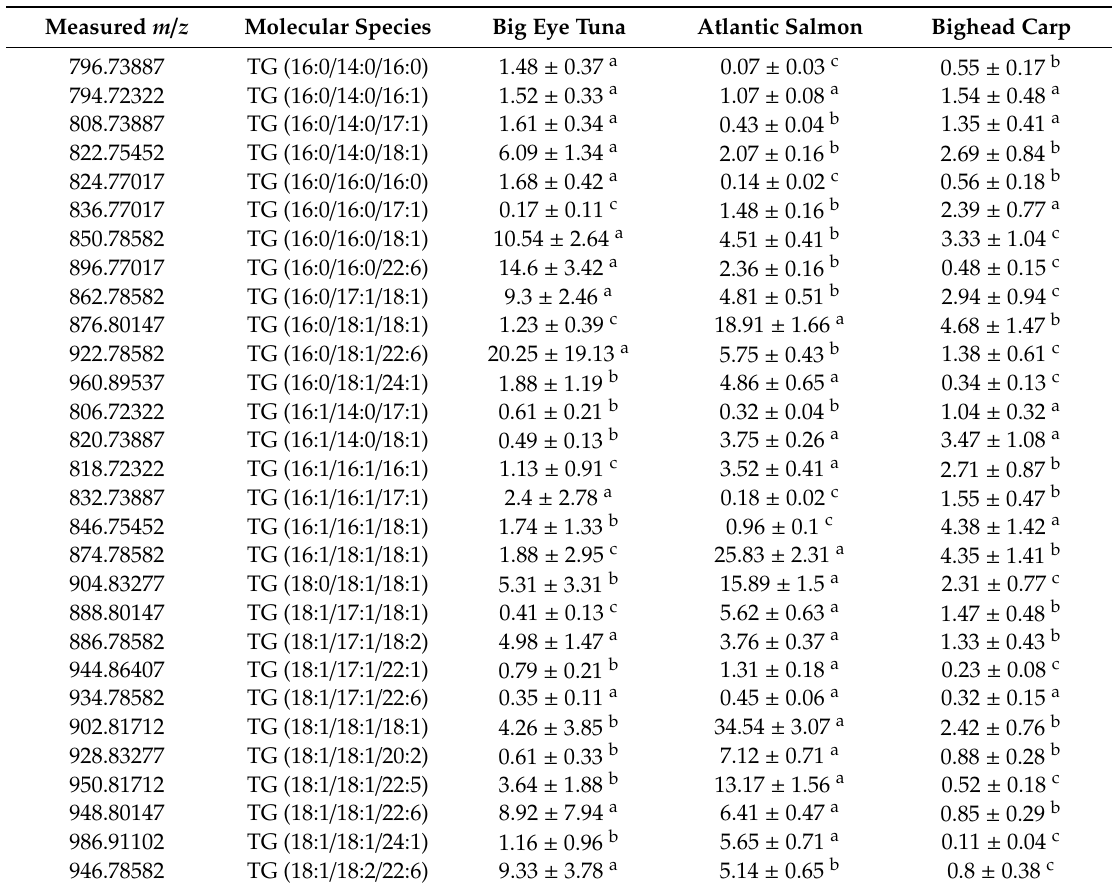
Table 2. Common triglycerides of the lipids recovered from big eye tuna, Atlantic salmon and bighead carp heads ( µ g / g